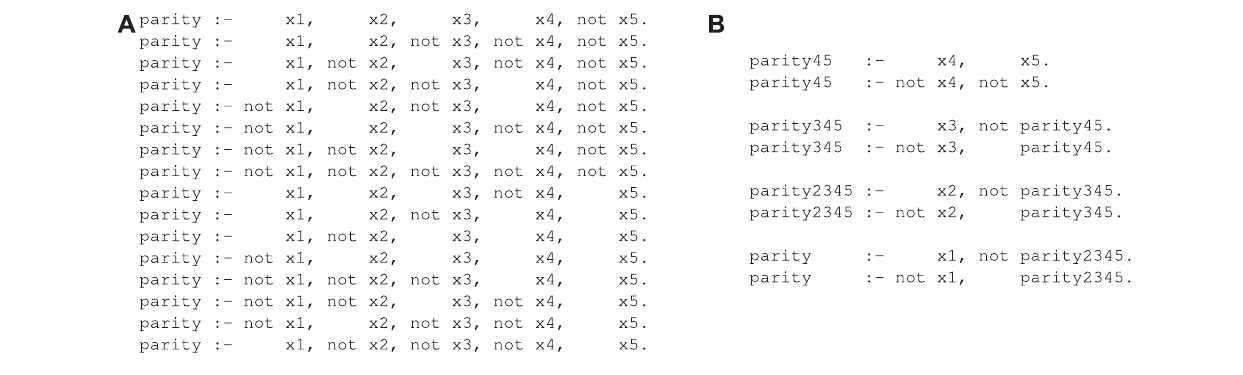
FIGURE1| Unstructuredandstructuredrulesetsfortheparityconcept. (A) A fl atunstructuredrulesetfortheparityconcept. (B) Adeepunstructuredrulebasefor parity using three auxiliary